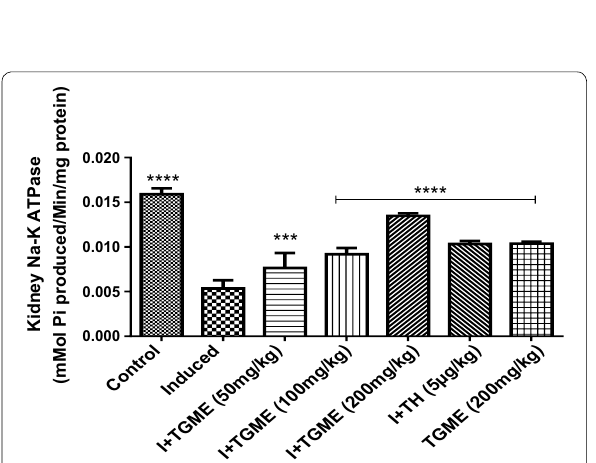
Fig. 17 Effect of aqueous methanolic leaf extract of Triclisia gilletii on SEM of 6 rats ( n 6); glutamine synthetase activity in the kidney of animals administered ± = ethane-1,2-diol. Data are expressed as mean ns* > 0.05, * p < 0.05, and **** p < 0.0001; *denotes that data were compared with ethane-1,2-diol; TGME Triclisia gilletii aqueous methanolic extract, TH tamsulosin hydrochloride